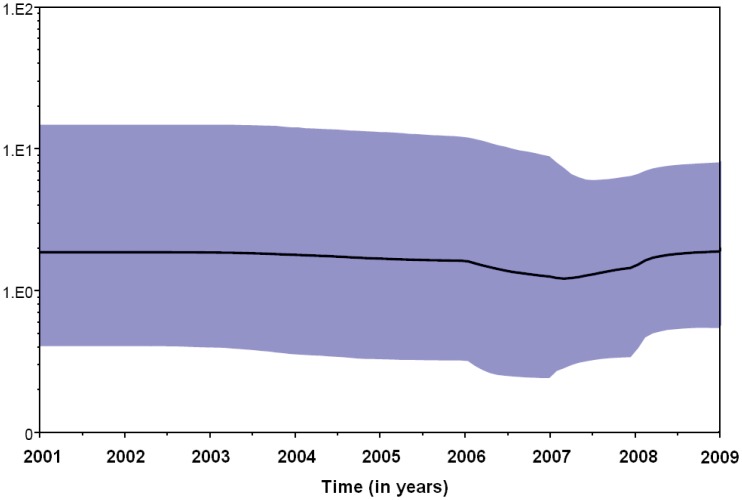
Bayesian skyline plot obtained by analyzing the 64 Beijing genotype 1E RV sequences.Ordinate: the number of effective infections at time; abscissa: time (in years). The thick solid line represents the median, and the blue area represents the 95% HPD of the number of effective infections at the time estimates.